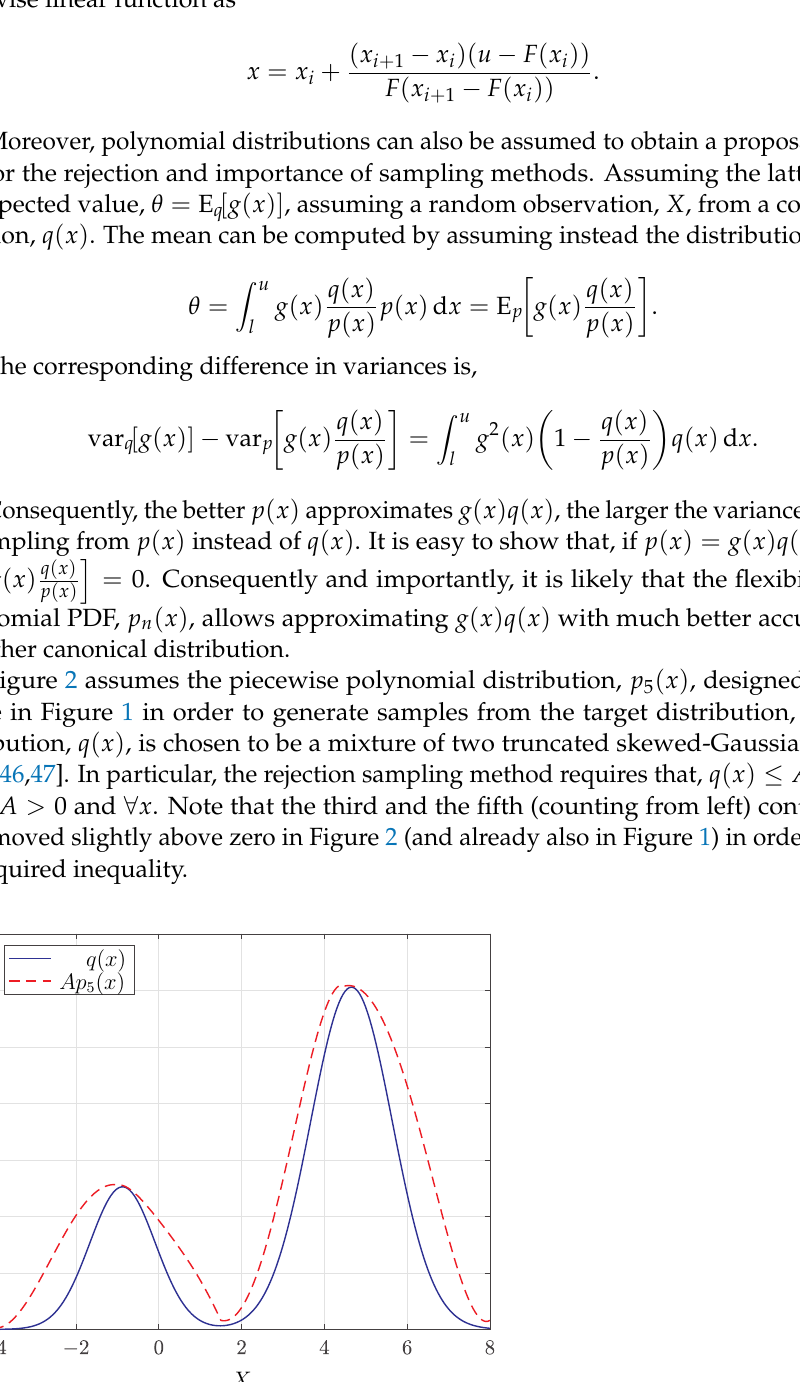
Figure 2. The rejection sampling from distribution p 5 ( x ) designed in Figure 1 to generate samples Ap 5 ( x ) , where A = from the target distribution, q ( x ) ≤